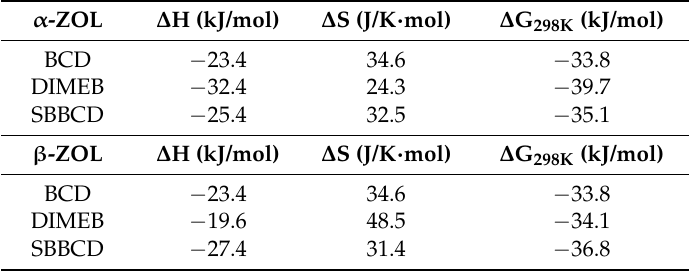
Table 3. Thermodynamic parameters of ZOL-CD interactions considering the dehydration of the guest molecules prior to the complex formation (based on modeling